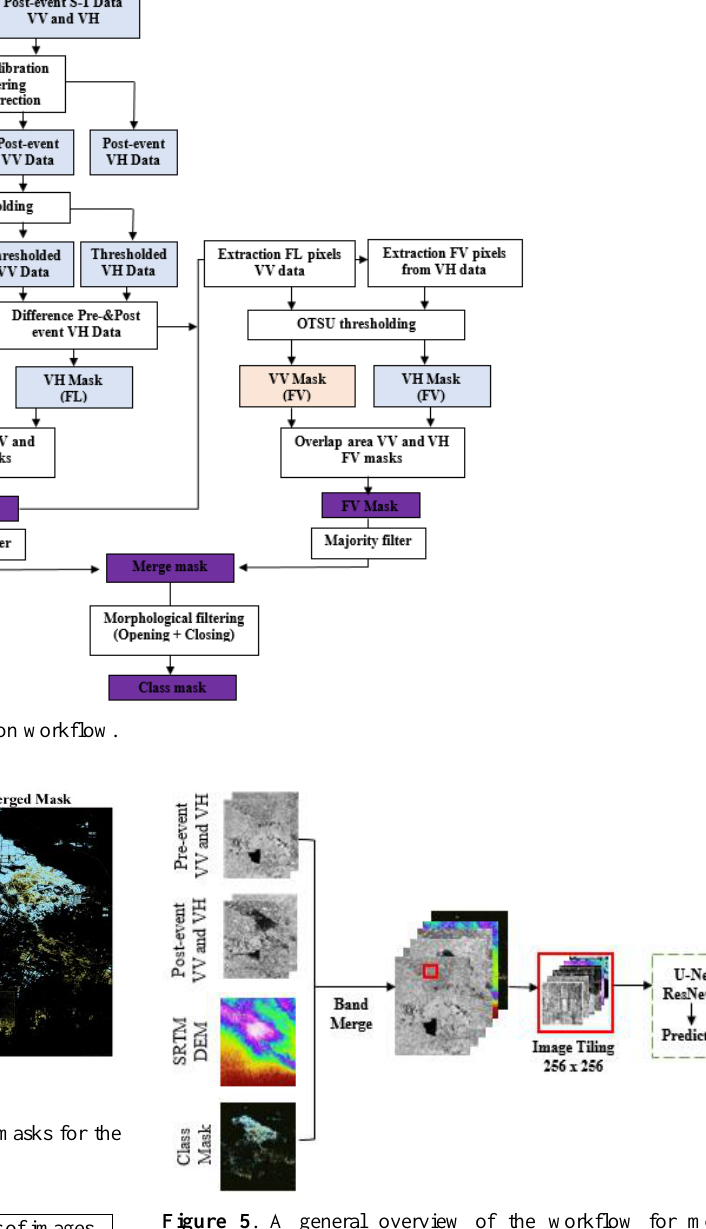
Figure 5 . A general overview of the workflow for model